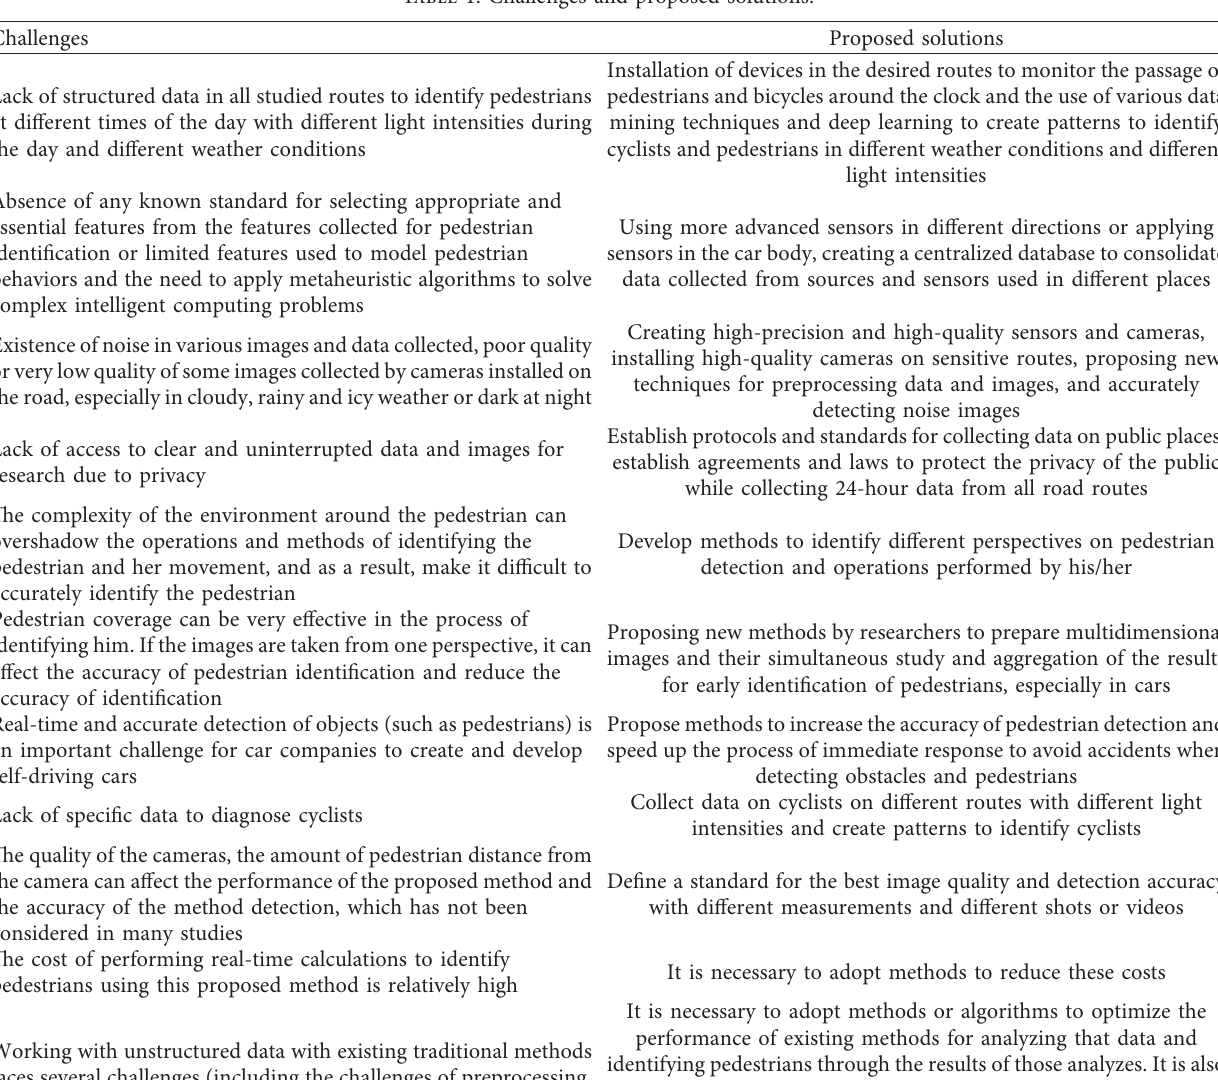
Table 1: Challenges and proposed